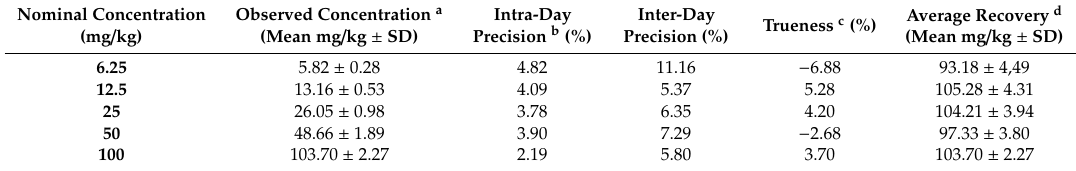
Table 2. Precision, accuracy, and recovery data for histamine in spiked canned tuna samples. Nominal Concentration (mg /